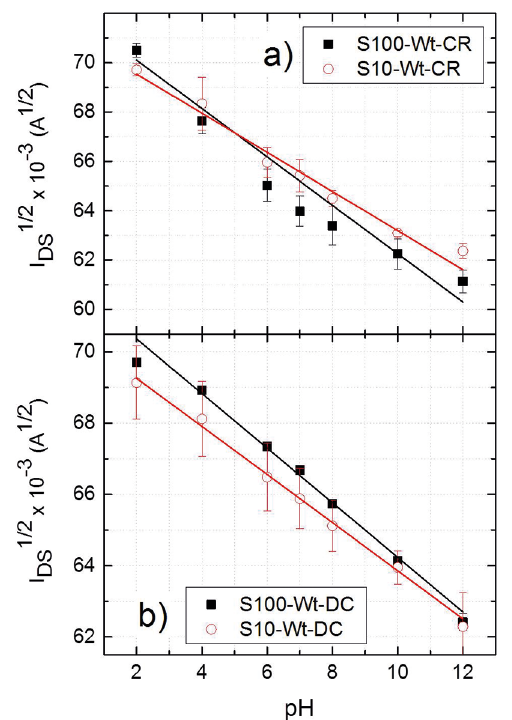
Figure 3. Resistivity influence for samples of 10 Ω/sq (red circles) and 100 Ω/sq (black squares) cleaned with water, on V for two pH sequences: a) Crescent sequence; b) Decrescent